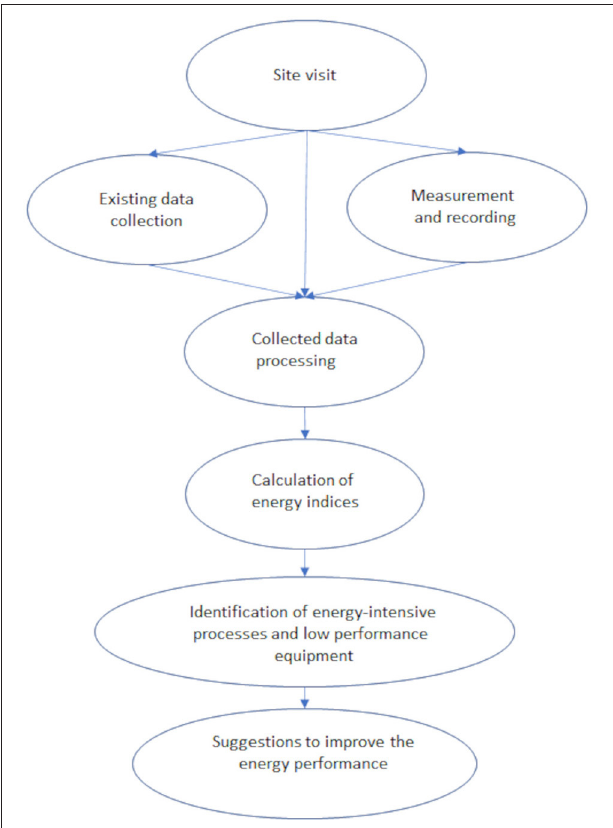
FIGURE 1 | Flowchart of the energy audit